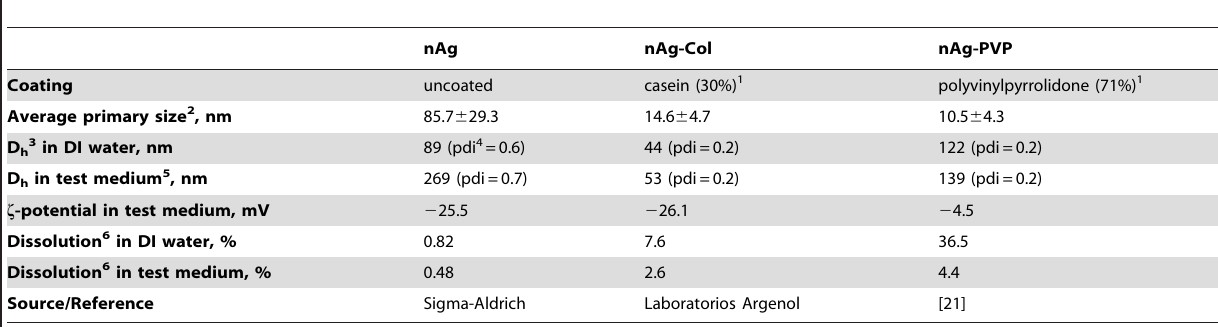
Table 1. Characterization of silver nanoparticles (AgNPs) used in the current study.